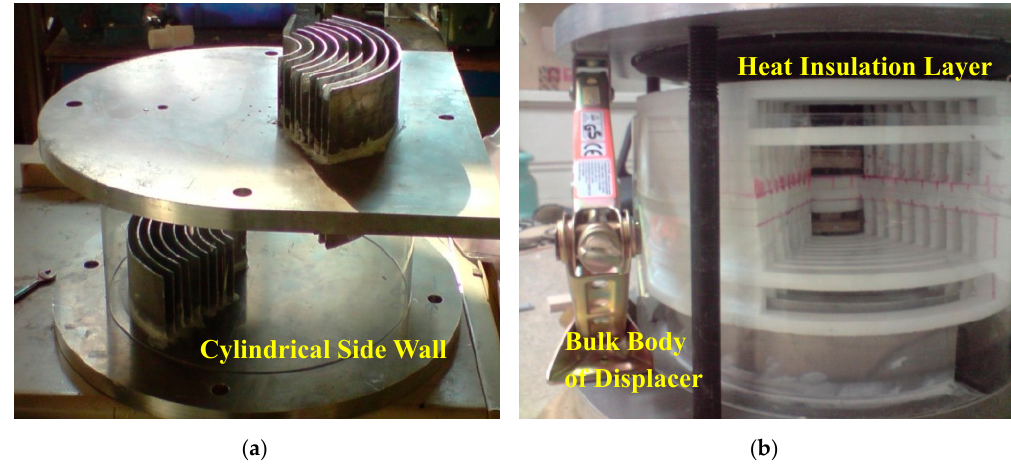
Figure 3. Fin arrays phasing ( a ), assembled with the displacer bulk ( b ).